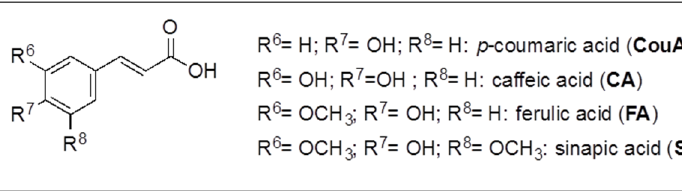
Scheme 3. Hydroxycinnamic acids (HCAs)